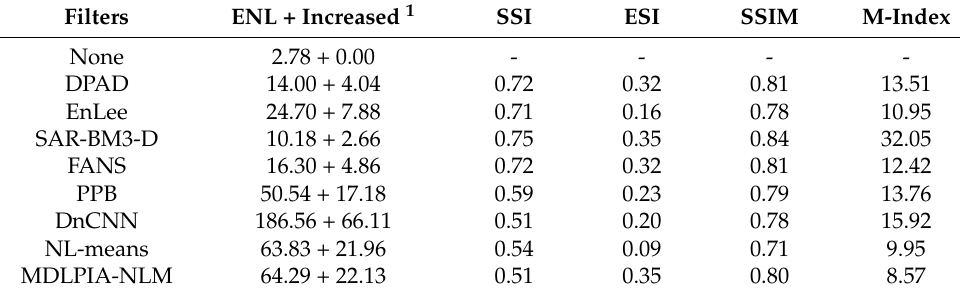
Table 3. Index evaluation on the GF-3 SAR image.